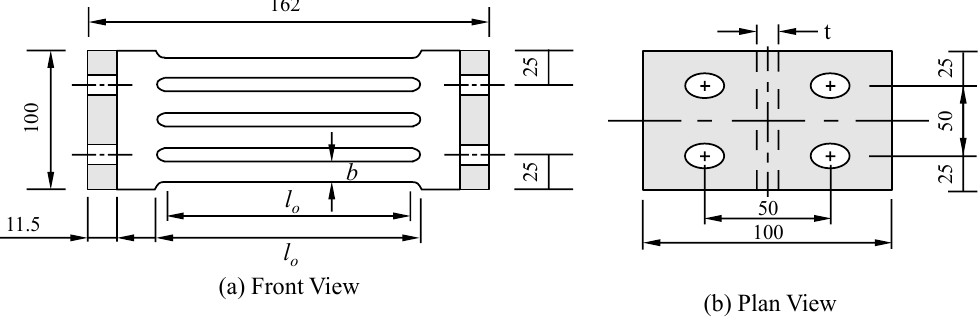
Figure 3. Geometric details for experimental slit damper (SL) models, ( a ): Front View, ( b ):